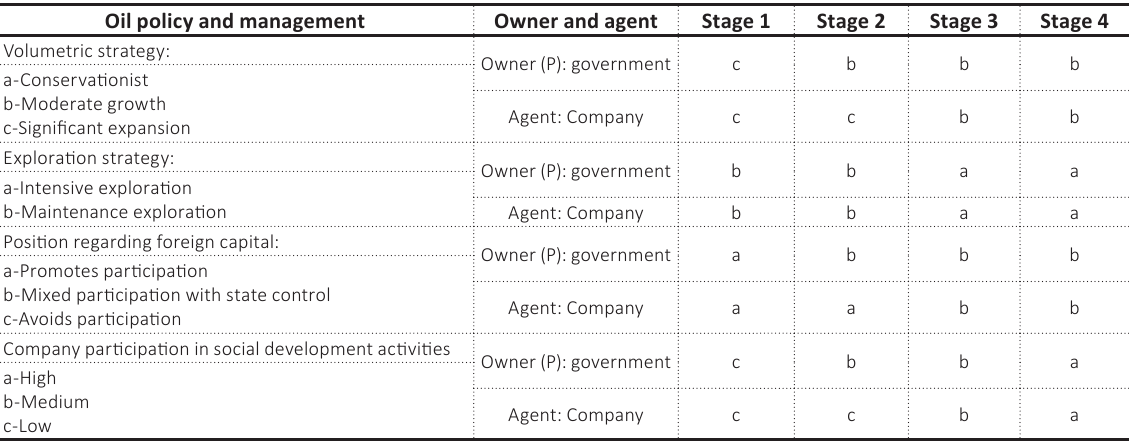
Source: Núñez and Pagliacci (2007).